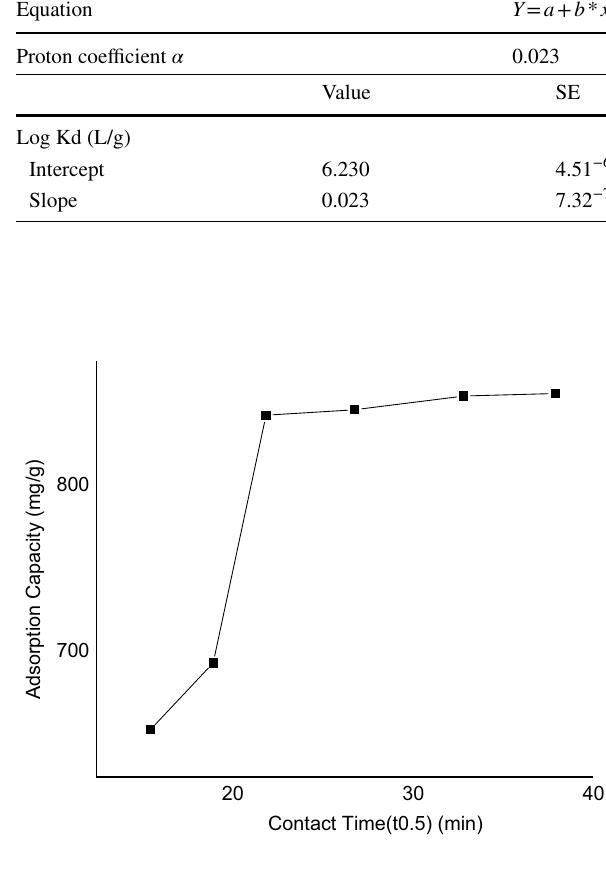
Fig. 6 Plot of adsorption capacity versus time for CuO–kaolinite composite used for the determination of intraparticle